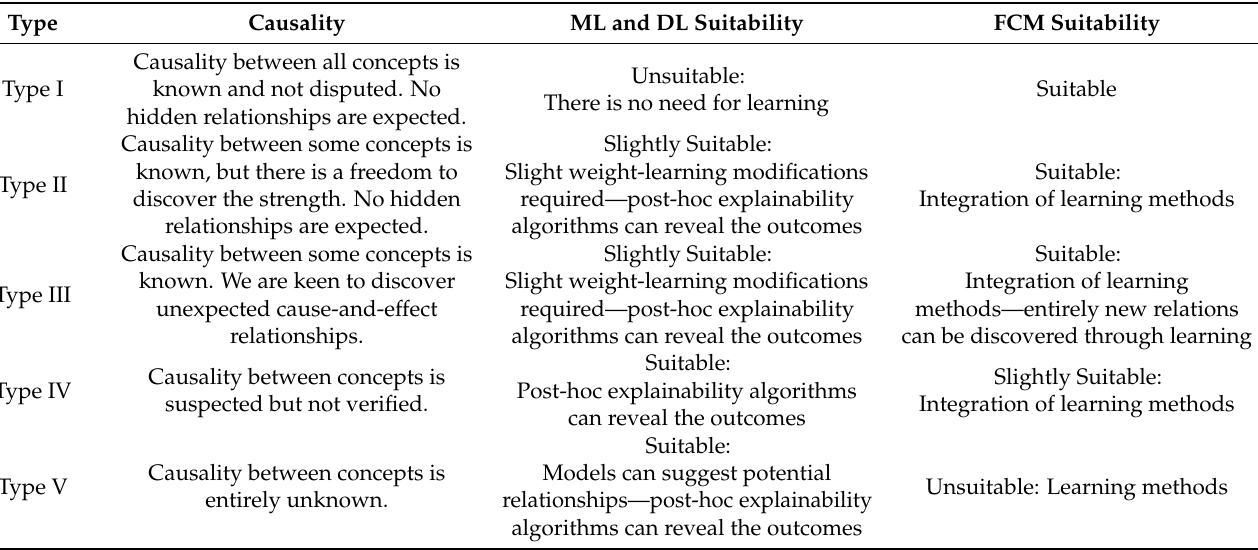
Table 3. Different types of expected/unexpected cause-and-effect relationships among the input data and the suitability of each